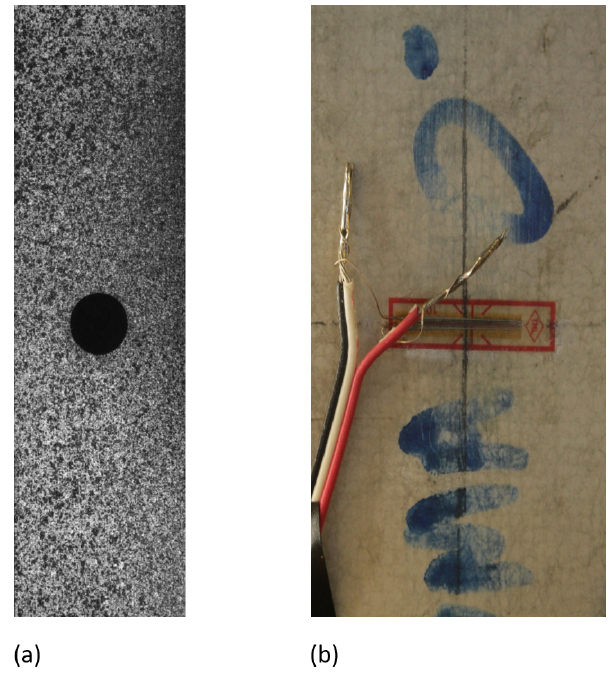
Figure 3. ( a ) “plate hole” sample image ( b ) GFRP sample